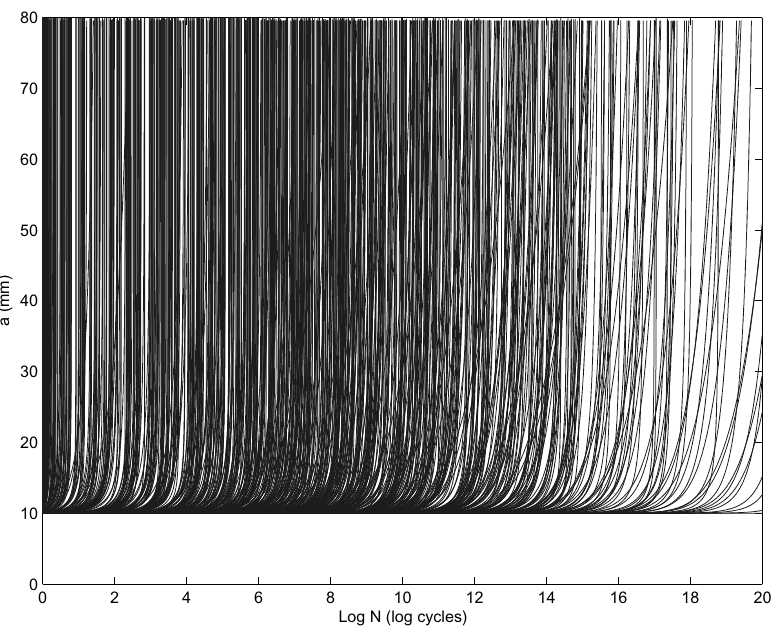
Fig. 3. Crack growth curves for first Monte Carlo